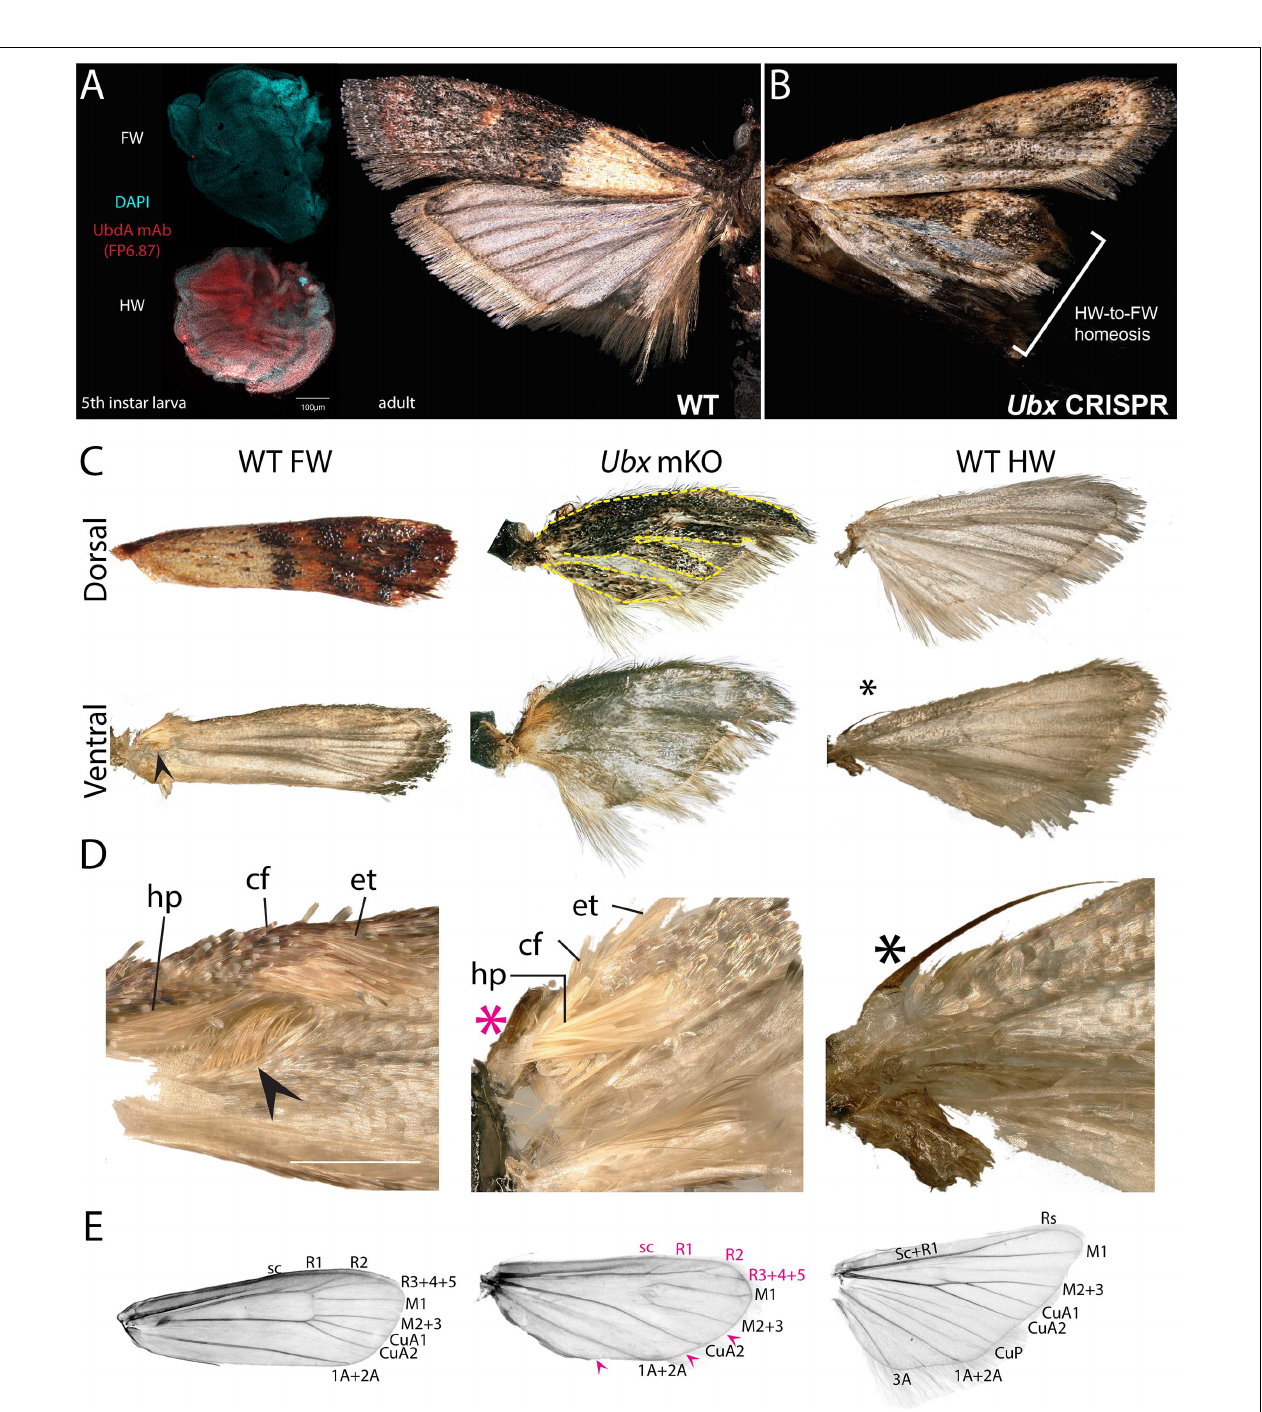
FIGURE 6 | Ubx controls hindwing specification in Plodia. (A) Left: Immunodetection of UbdA in fifth instar larval wing disks (FP6.87 mAb, red; DAPI, cyan). Right: wild-type P. interpunctella (dorsal view). (B) Ubx mKO individual with transformation in pigmentation and wing rigidity. (C) Dorsal and ventral surfaces of a WT forewing, Ubx mKO and WT hindwing from male specimens. The mutant hindwing takes a concave appearance, loses its posterior folds and shows transformed dorsal black/brown patterns with a forewing identity (dashed lines). (D) Magnified ventral view of the wing base. Wing coupling uses a frenulum (black asterisk) engaging into a retinaculum (arrowhead). Male forewings also possess an extendable scent apparatus. The Ubx crispant hindwing shows a defective frenulum (magenta) and an ectopic scent apparatus with fully developed hairpencils (hp); cf: costal fold; et: external tuft of hair. (E) Wing venation of a de-scaled adult female forewing, Ubx mKO and hindwing. The Ubx mosaic KO shows homeoses of anterior veins toward the forewing venation (magenta letters) and loss of a few veins (magenta arrowheads). Vein nomenclature adapted from the phycitine moth wing plan (Solis and Neunzig, 2017). Scale bars: A = 100 µ m; D = 500 µ m.